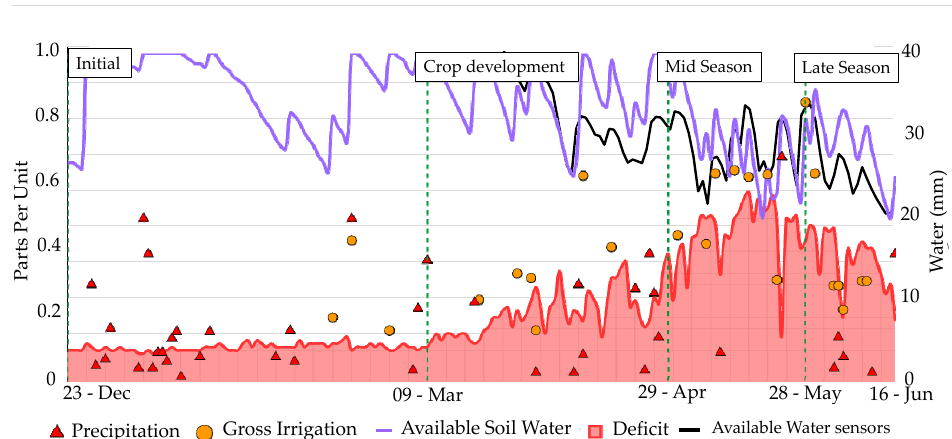
Figure 3. Evolution of available soil water (AW; main Y axis) simulated by online MOPECO model for LEADER using SUPROMED tool (LEA SUP ) in 2021 and comparison with measured (Drill & Drop, Senteck) available soil moisture progression in LEA SUP (2021) (available water sensors; main Y axis). Where deficit (main Y axis): 1-p, where p is the fraction of total available water (TAW) that a crop can extract without suffering from water stress. Secondary Y axis: gross irrigation; precipitation.